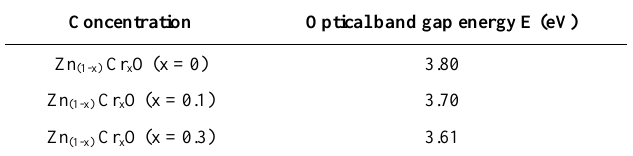
Table 2. Optical band gap energy of Zn (1-x) Cr x O (x = 0, 0.1 and 0.3)